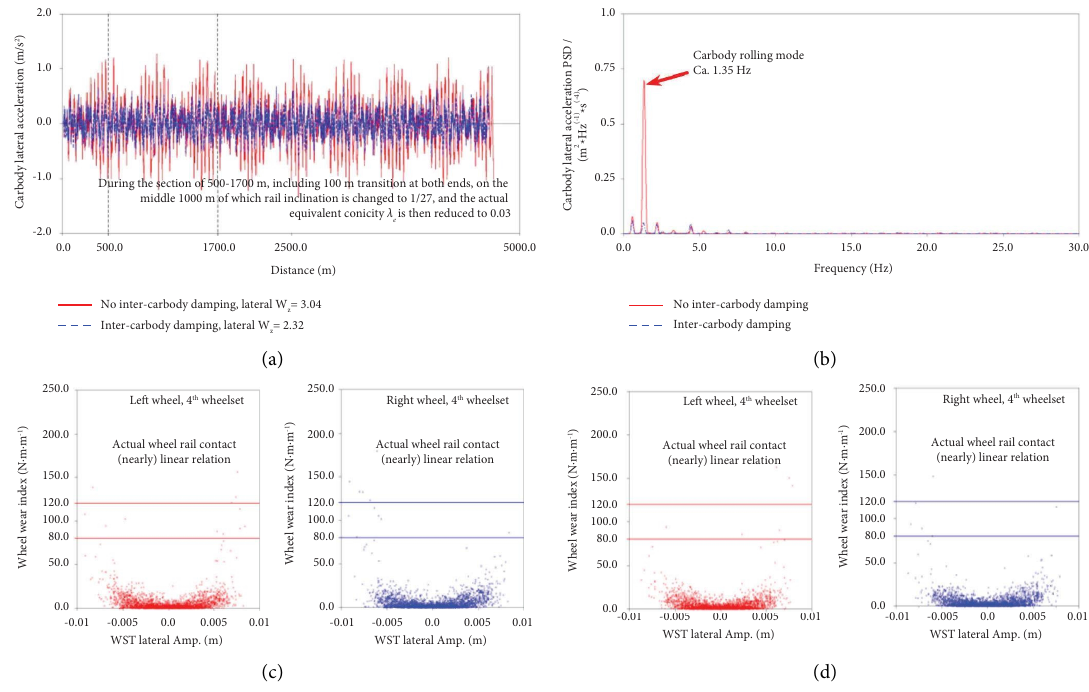
Figure 6: Efective assessments of the semiactive damping technique at MC03 under variable track conicity conditions. (a) Lateral ac- celeration contrast at the rear-right point on the car body foor. (b) Lateral acceleration PSD contrast at the rear-right point on the car body foor. (c) Distribution contrast of wheel wear index characteristics when intervehicle damping is of. (d) Distribution contrast of wheel wear index characteristics when intervehicle damping is